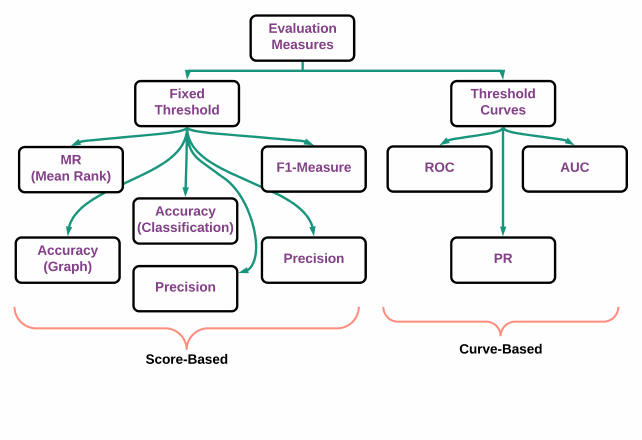
Figure 13. Taxonomy of Performance Evaluation